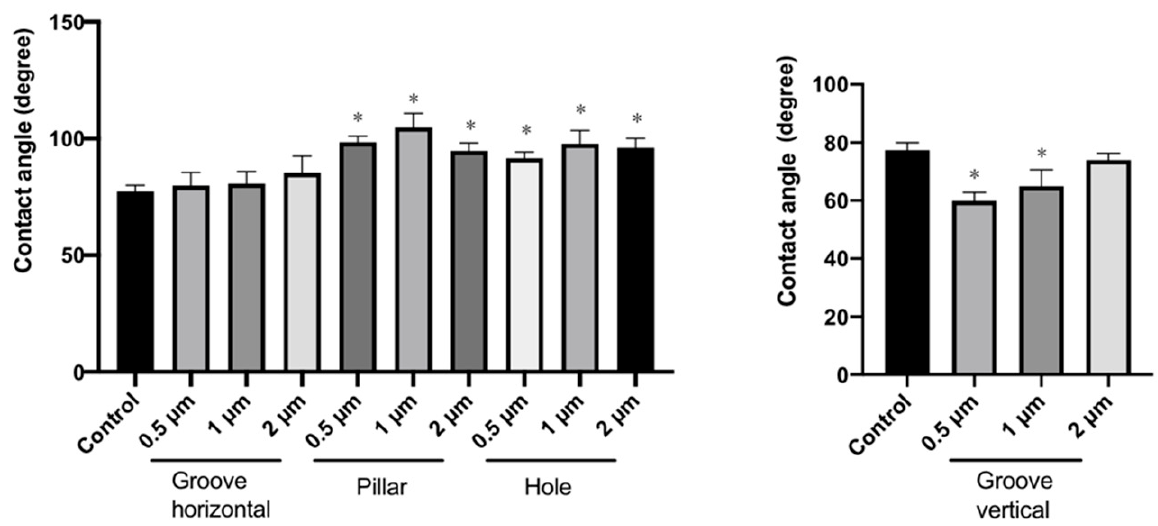
Figure 5. Contact angle measurement data. The contact angle was normalized to that of the control (non-pattern). (* indicates p < 0.05).